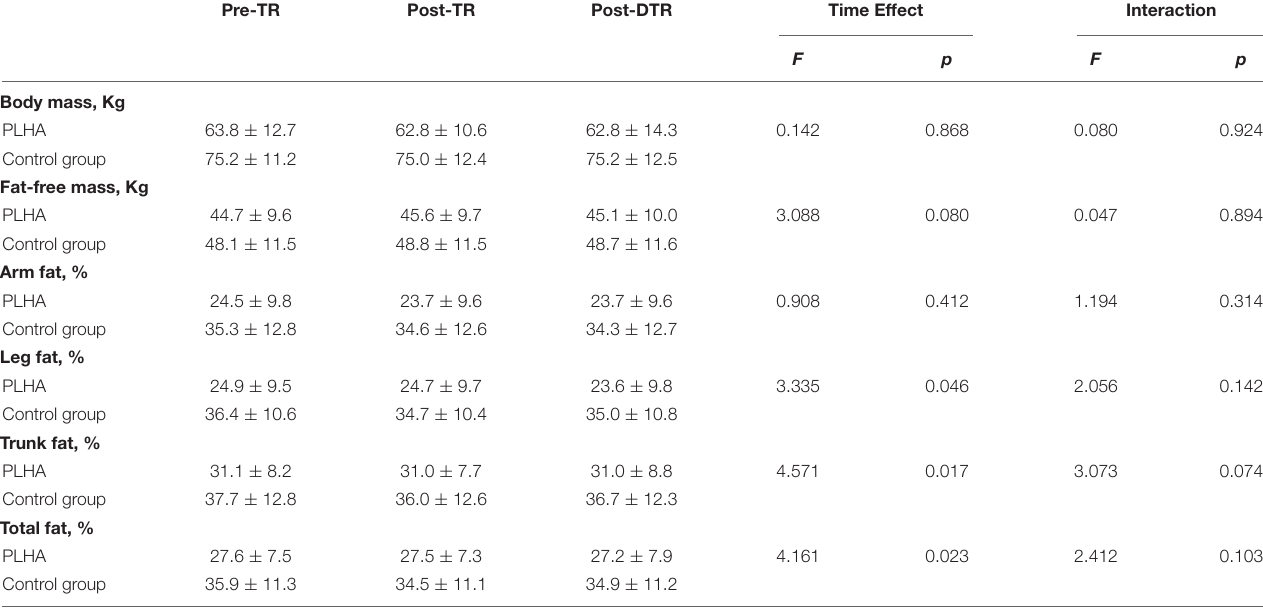
TABLE 3 | Descriptive and inferential results of body composition variables pre-training (Pre-TR); post-training (Pos-TR); and post-detraining (Post-DTR) for PLHA and CG. Pre-TR